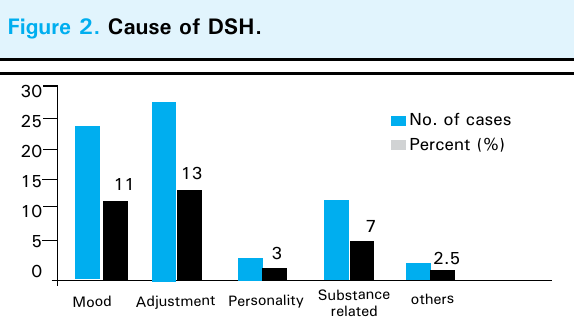
Figure 2. cause of DsH.